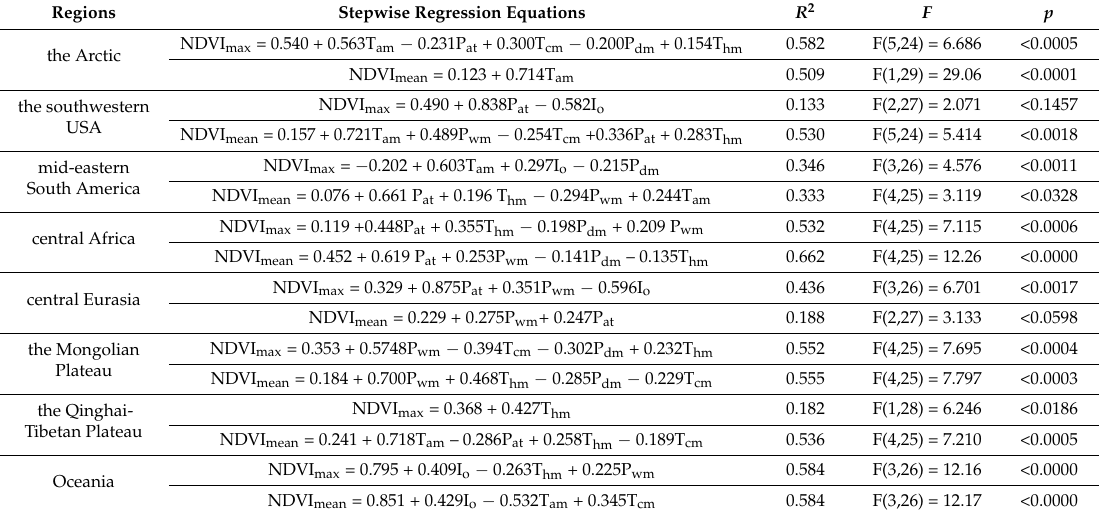
Table 4. Stepwise multiple regression between NDVI and bioclimatic factors of OGFD ecosystems in different regions from 1982 to 2011. The NDVI max is the annual maximum values of NDVI; NDVI mean is the annual mean values of NDVI; P at is annual total precipitation (mm); P wm is the precipitation of the wettest month (mm); P dm is the precipitation of the driest month (mm); T am is annual mean temperature ( ˝ C); T hm is the mean temperature of the hottest month ( ˝ C); T cm is the mean temperature of the coldest month ( ˝ C); and I o is the ombrothermic